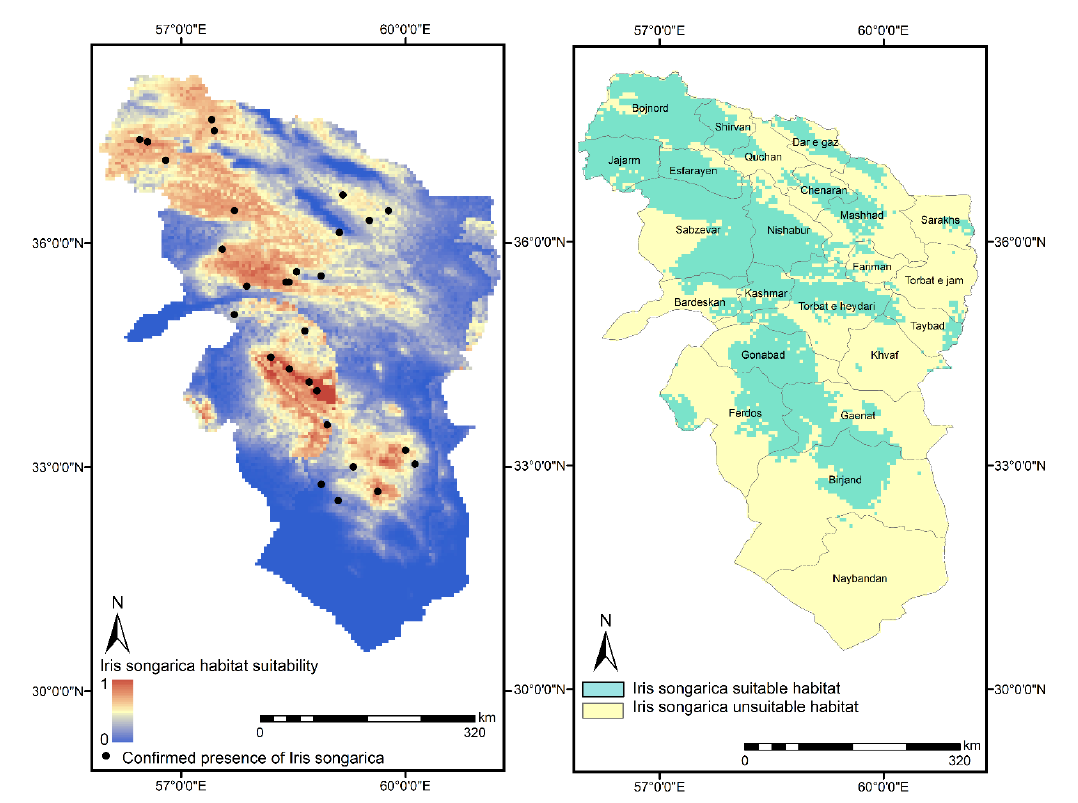
Fig. 3: Habitat suitability of Iris songarica and its suitable habitats in the cities of Khorasan region.